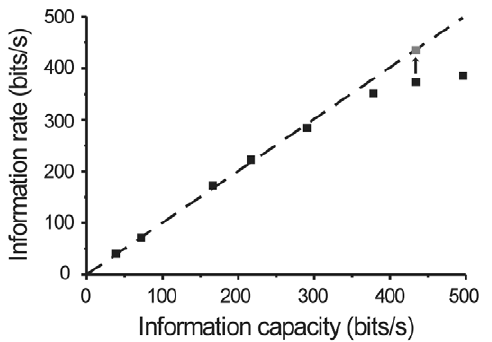
Figure 2. Information rate vs. information capacity of a Gaussian channel. Grey square corresponds to the estimate from 600000 data points.